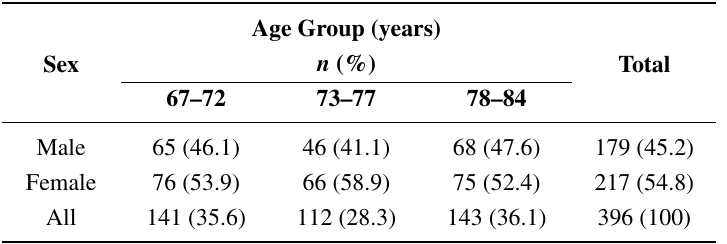
Table 1. NuAge participants with complete data in both dietary data collection instruments, SDQ validation study ( n = 396).